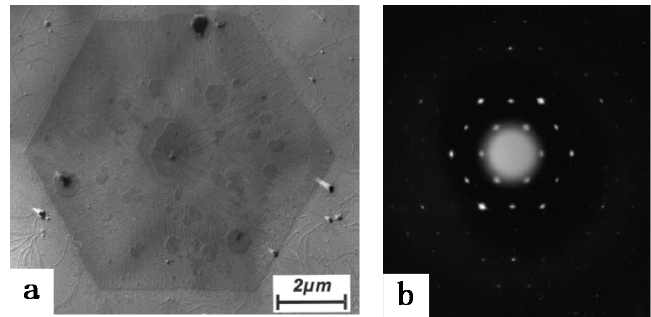
Figure 4. Bright field electron micrograph ( a ) and corresponding diffraction pattern ( b ) of iPBu form I crystallized directly from the melt after heating up to 125 °C for 15 min and then cooled to room temperature. Reproduced with permission from Ref. [33], copyright 2002 Wiley Periodicals, Inc.